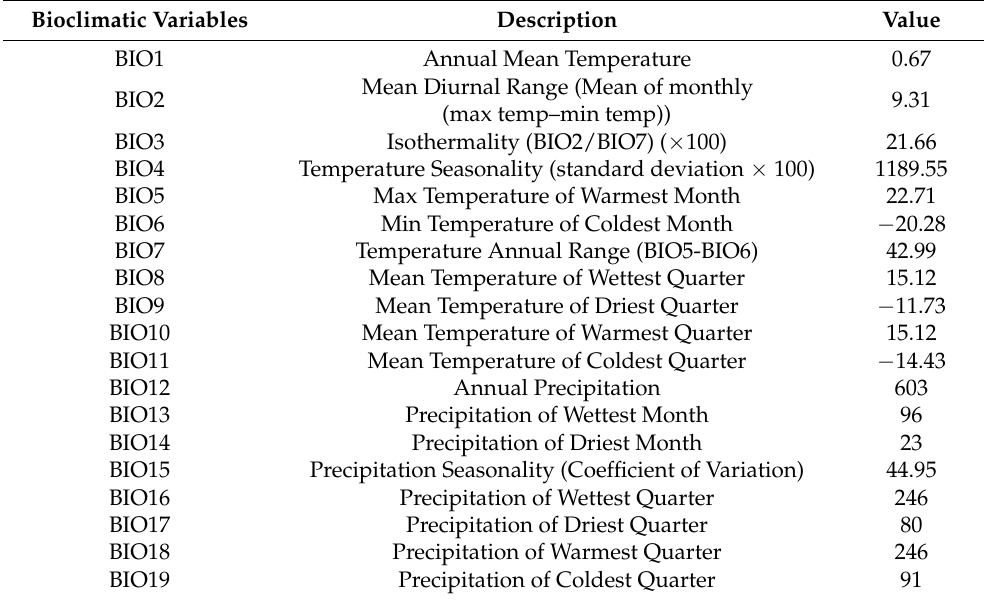
Table 2. Bioclimatic variables for the studied mountain stony shrub-moss-lichen tundra of the Northern Urals (WorldClim version 2.1 climate data for 1970–2000 [29]. Bioclimatic